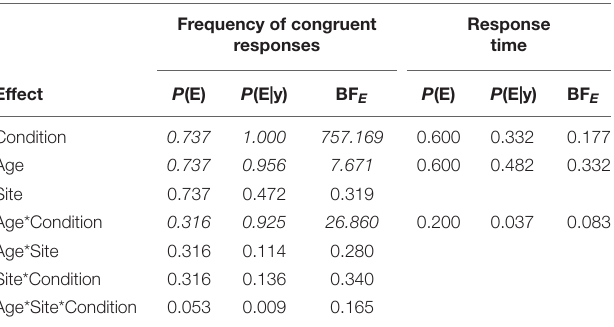
Terms are sorted by complexity and posterior probability, and highlighted in italics when part of the winning model. P(E), prior probability; P(E| y), posterior probability; BF E , Bayes factor favoring inclusion of the